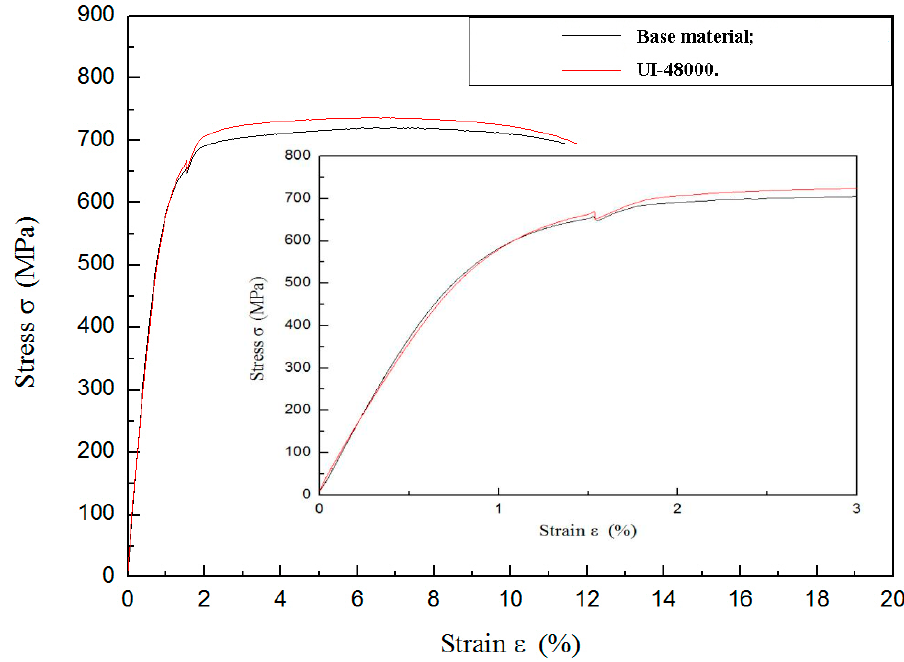
Figure 6. Tensile stress-strain test for TLM titanium alloy.